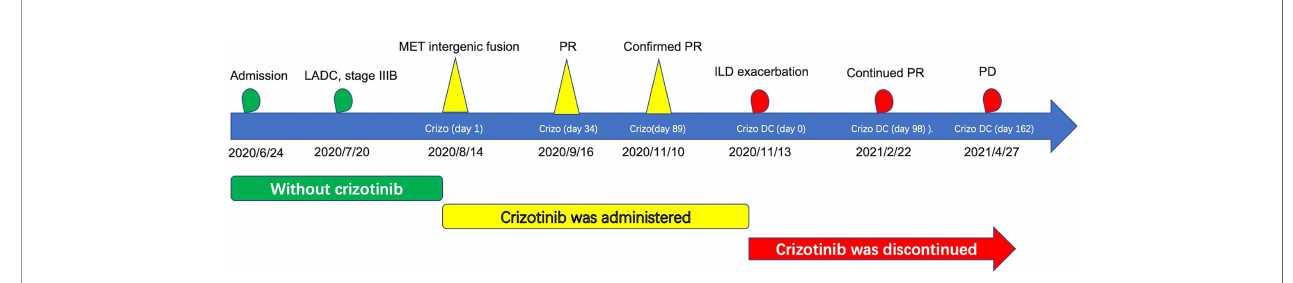
FIGURE 4 | Historical and current information from this episode of care organized as timeline. LADC, lung adenocarcinoma; MET, mesenchymal – epithelial transition factor; PR, partial response; PD, progressive disease; ILD, interstitial lung disease; Crizo, crizotinib; Crizo DC, crizotinib was